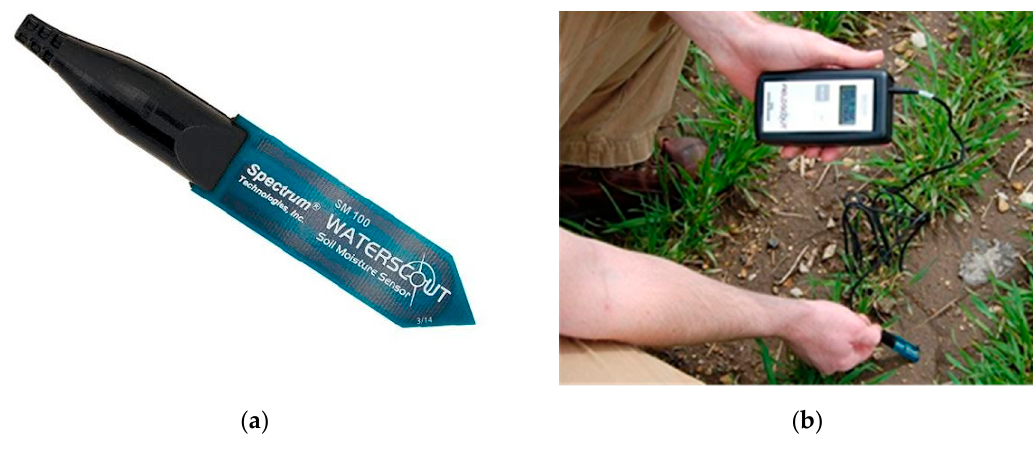
Figure 4. ( a ) The WaterScout SM100; ( b ) The FieldScout pocket Soil Sensor Reader.